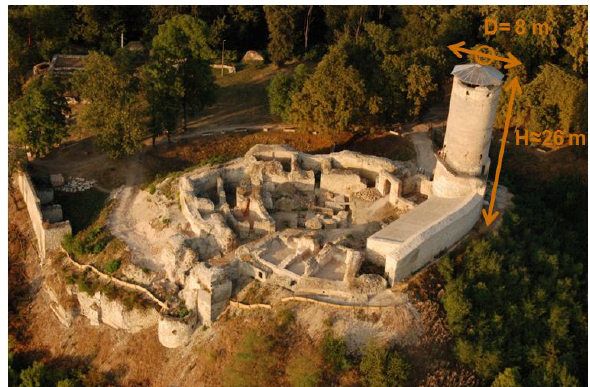
Figure 2: General view of the tower of the castle in Iłża